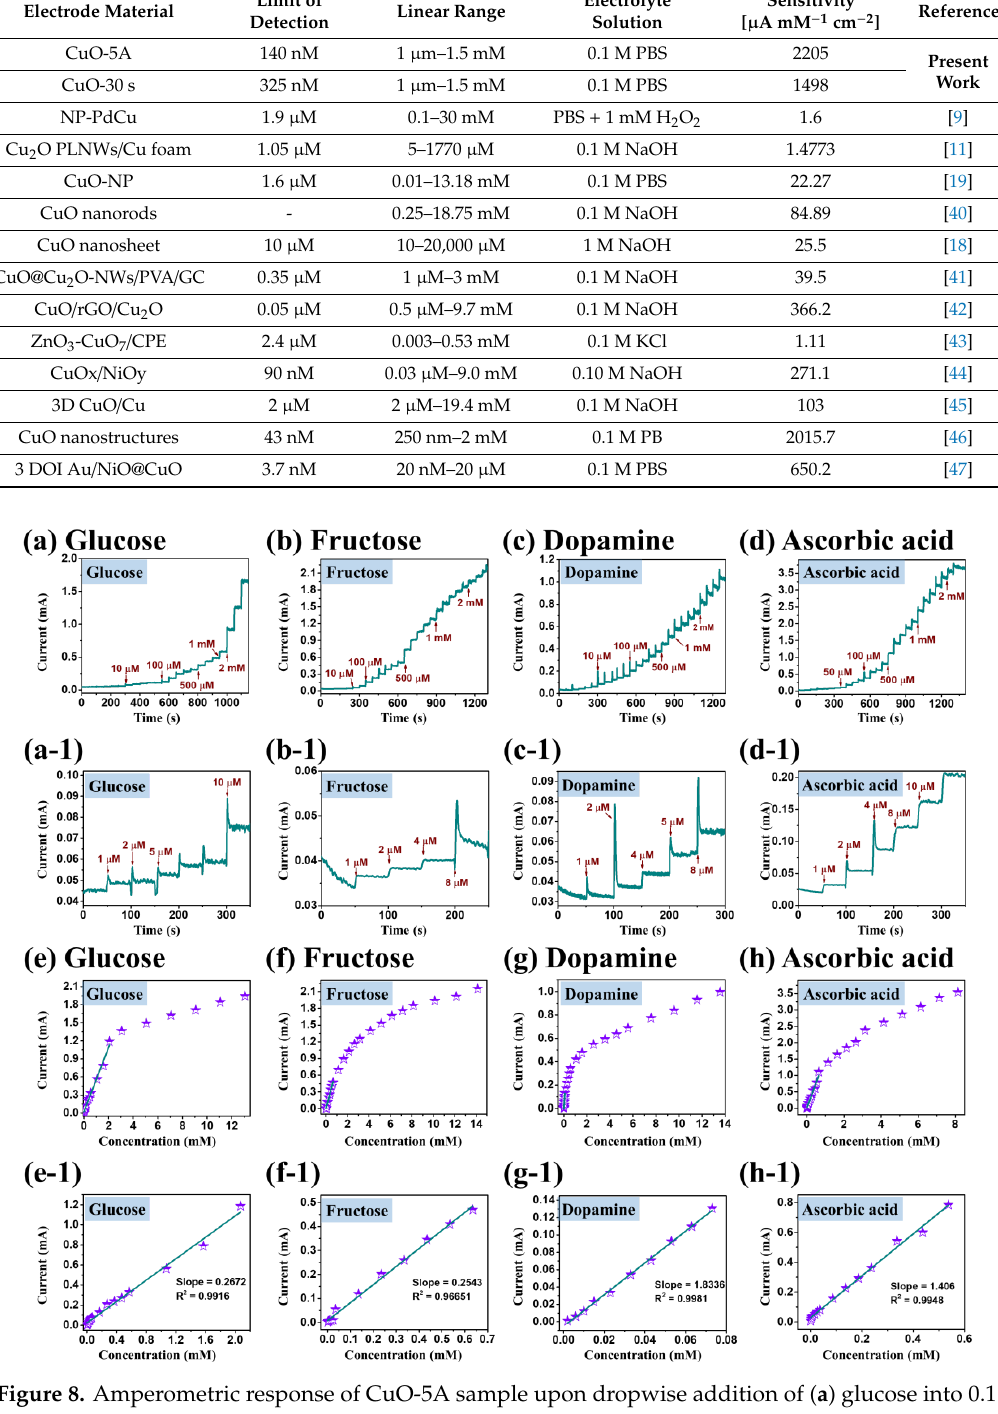
Table 1. Comparison of electrochemical H 2 O 2 sensing performance for the CuO-based materials. Electrode Material